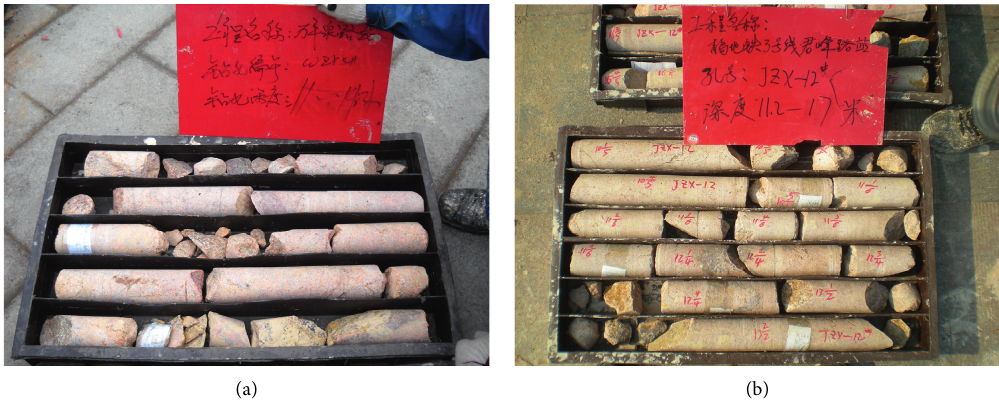
Figure 2: Rock drilling sampling diagram. (a) Wannianquan Road Station (b) Junfeng Road